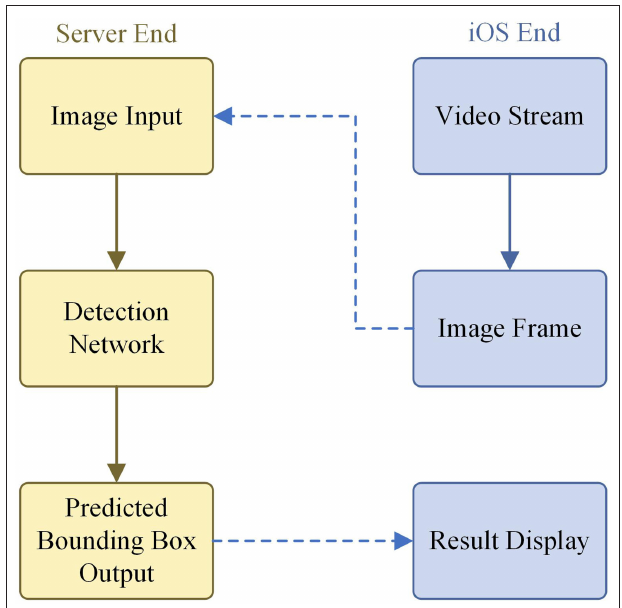
FIGURE 8 | Intelligent wheat detection system